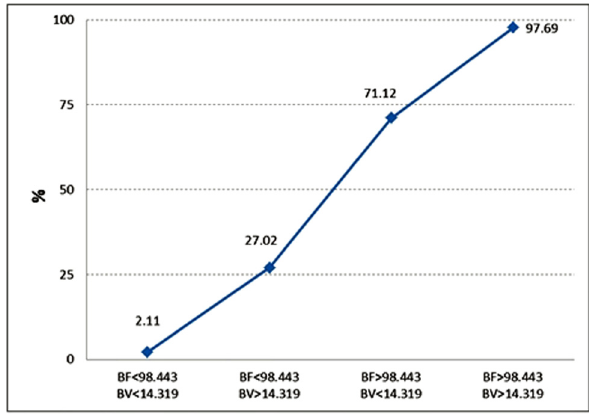
Figure 5: Estimated probability for the presence of